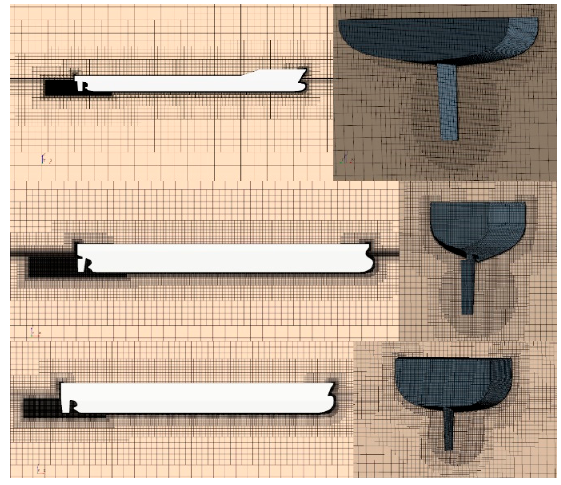
Figure 6. The profile view cross-section of the domain for KCS ( upper left ), KVLCC2 ( middle left ) and BC ( lower left ) and mesh refinement in stern region of KCS ( upper right ), KVLCC2 ( middle right ) and BC ( lower right ).